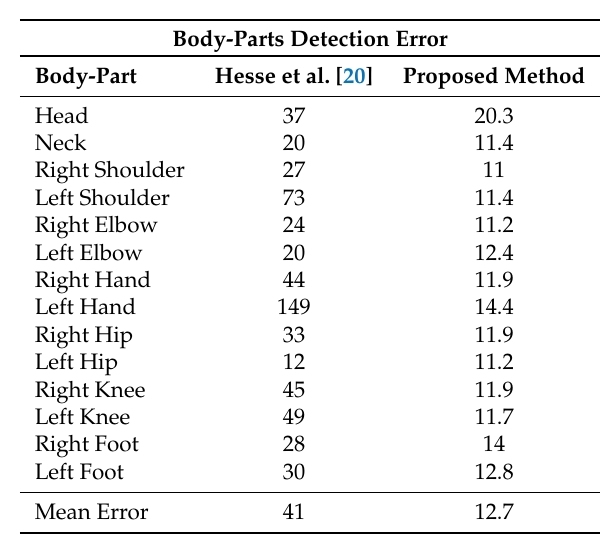
Table 2. Average joint position error measure the average difference (in millimeter) between the predicted and the ground truth locations. The error is reported per body part and Mean Error represents the average error across all the body parts in the test dataset. The proposed method outperforms in the detection of each body (i.e., having minimum